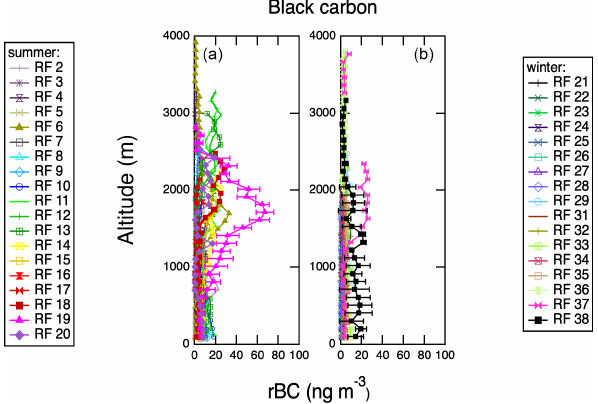
Figure 10. Vertical profiles of refractory black carbon (rBC) ac- quired with SP2 during spiral profiles shown in Fig. S1. Represen- tative error bars (1 σ standard deviations) are shown on 1d only for clarity. (a) IOP 1. (b) IOP